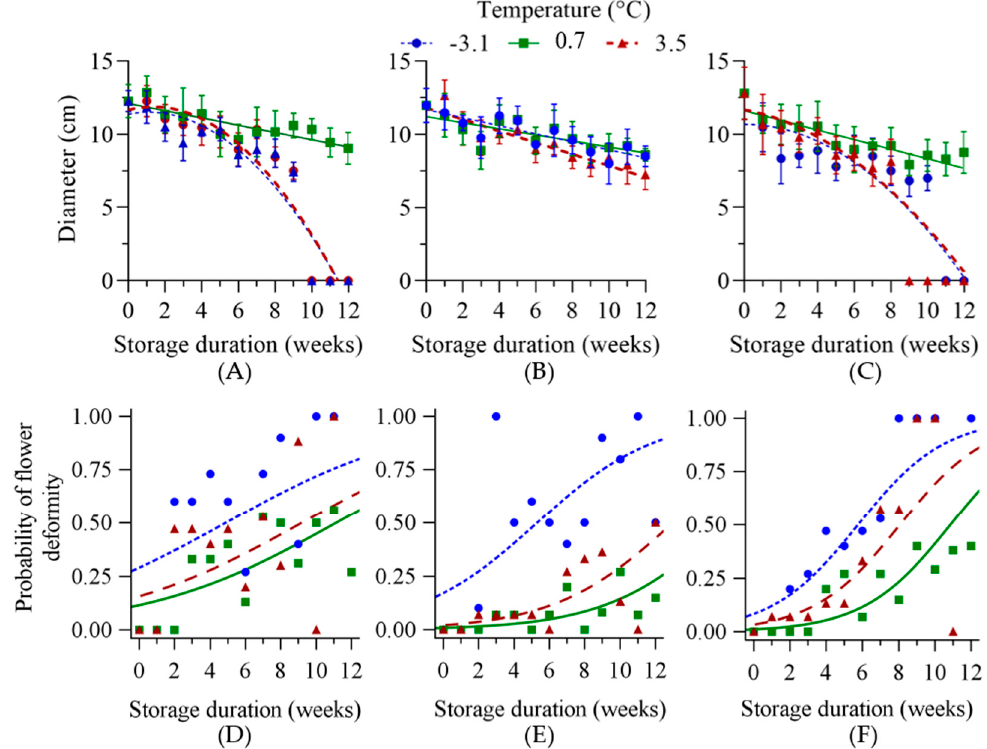
Figure 2. Exp1 diameter ( A – C ) and probability of deformed flowers ( D – F ) for Paeonia lactiflora cultivars Festiva Maxima ( A , D ), Monsieur Jules Elie ( B , E ), and Sarah Bernhardt ( C , F ) in response to three storage temperatures and thirteen storage durations. Buds that failed to open or flowers that partially opened and, petals that did not complete reflex or unfold were labeled as FTO during post-storage evaluation. Flowers were considered deformed if petals did not fully expand, were missing, were wrinkled, or exhibited some type of disfigurement. Markers for diameter are the least squared means along with ± SD ( n ≤ 15) with linear or quadratic regressions. Least squared means were used to account for missing samples when the flowers did not open. Logistic regressions are the predicted deformity probability along with the observed percentage as a decimal ( n ≤ 15). Regression models and fit statistics are located in Tables S4–S6.